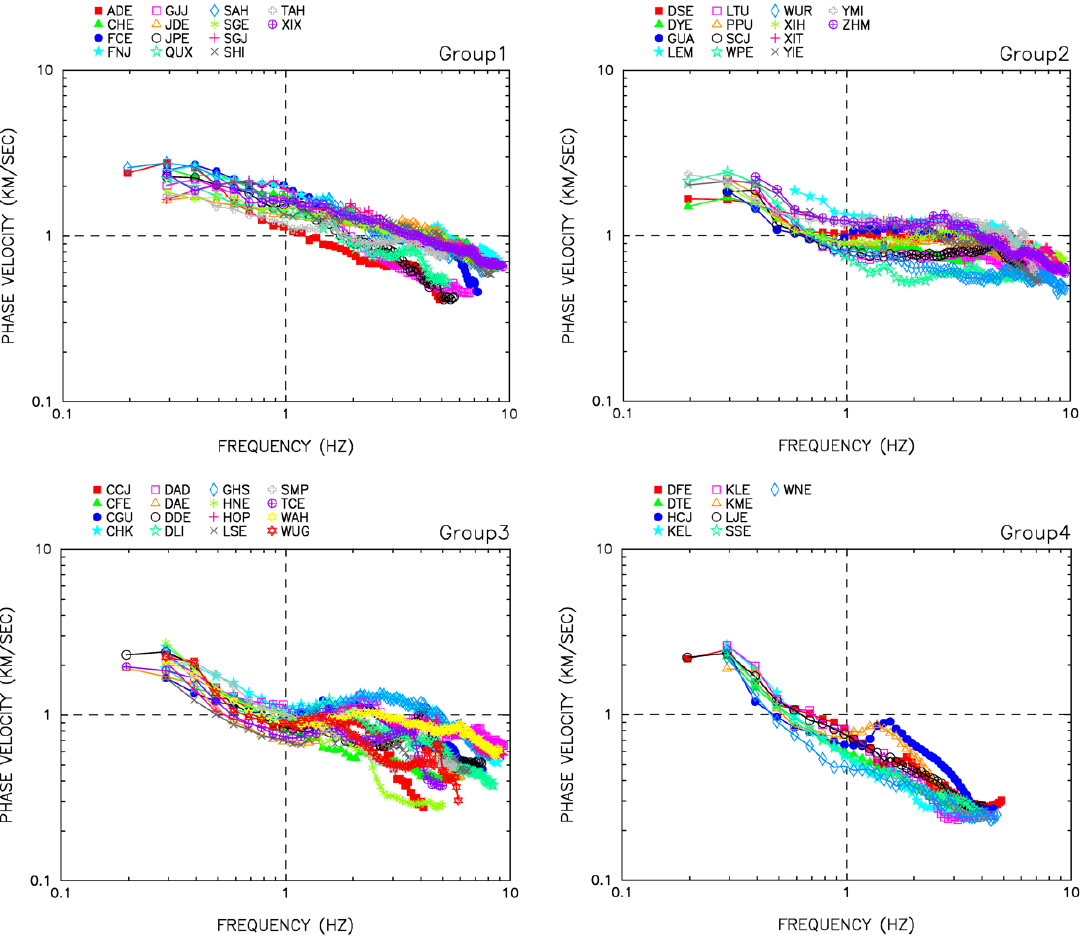
Figure 7. Phase velocities obtained from recordings observed at all 53 arrays. The estimated phase velocities vary between sites.